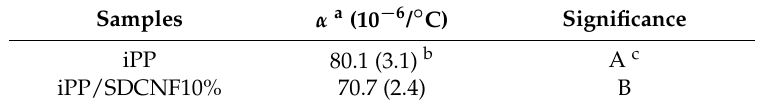
Table 7. Coefficient of thermal expansion of iPP and iPP/SDCNF